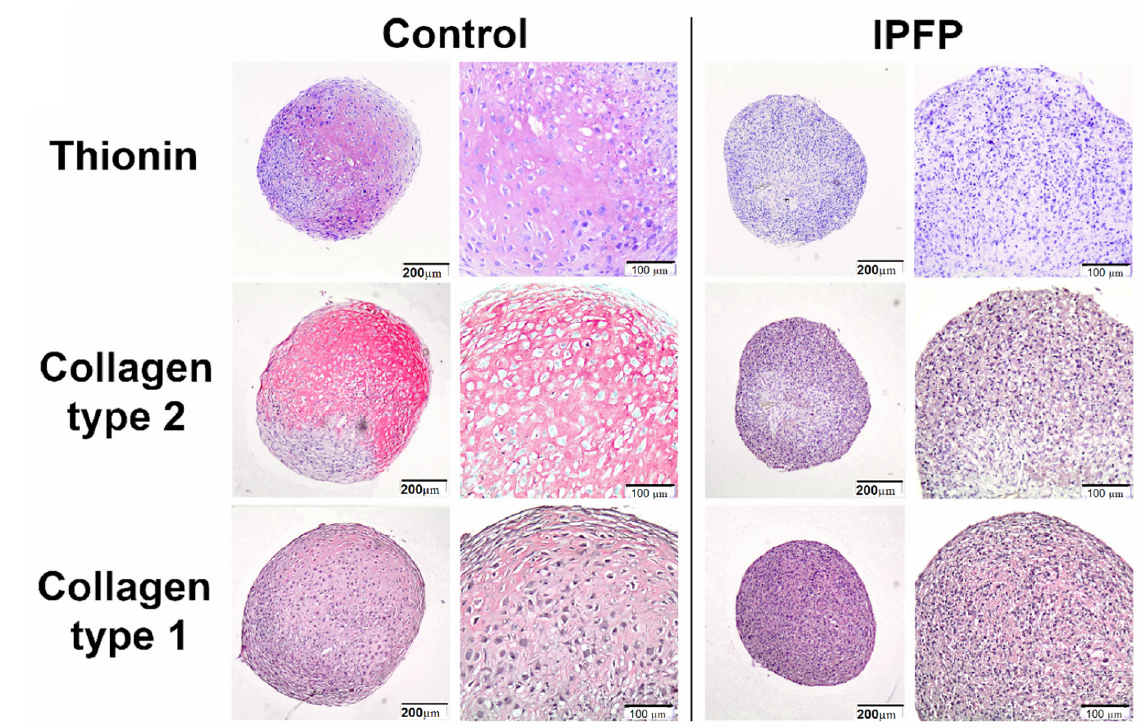
Figure 1. IPFP inhibits chondrogenic differentiation of MSCs. Immunohistochemically stained images of pellets from MSC donors for glycosaminoglycans with thionin or collagen type II and collagen type I showing IPFP decreased thionin and collagen type II, whereas collagen type I staining was not affected. Reproduced with permission [65]. Copyright 2015, Elsevier.